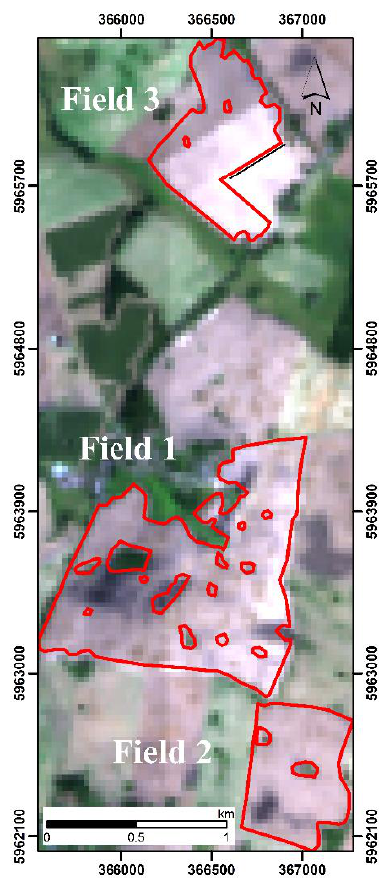
Figure 3. EnMAP simulated image (red: 639.21 nm, green: 548.06 nm; blue: 459.59 nm) and the borders of the field 1, 2 and 3.